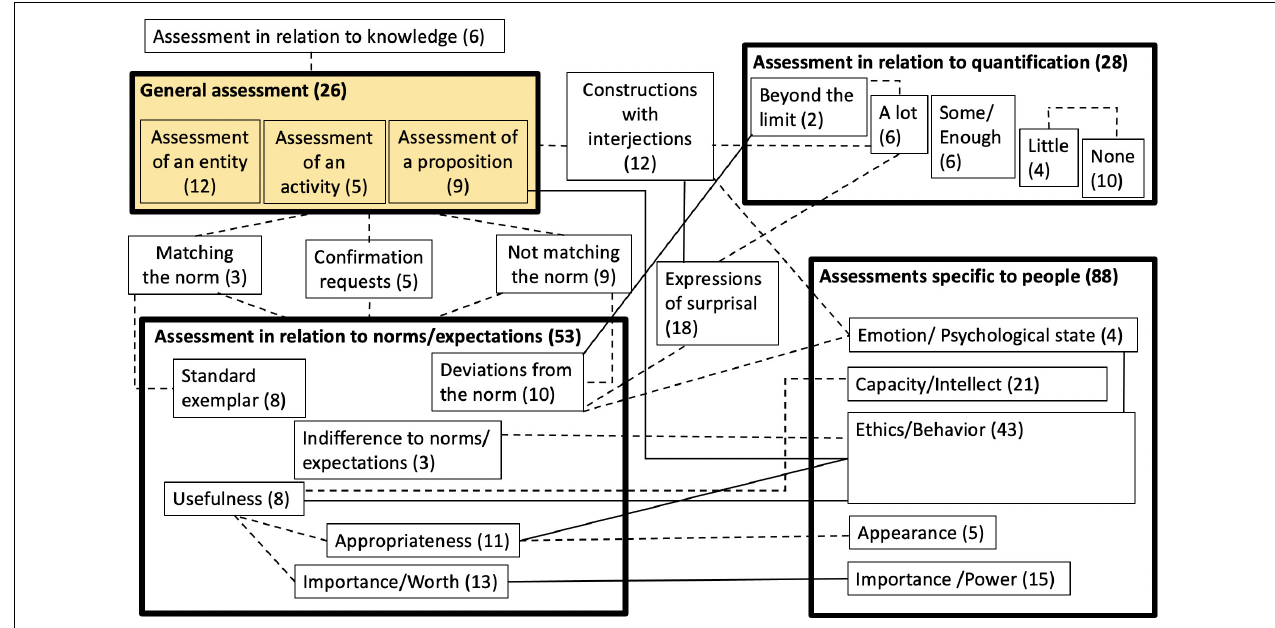
FIGURE 3 | A radial category model of the network of Assessment constructions.